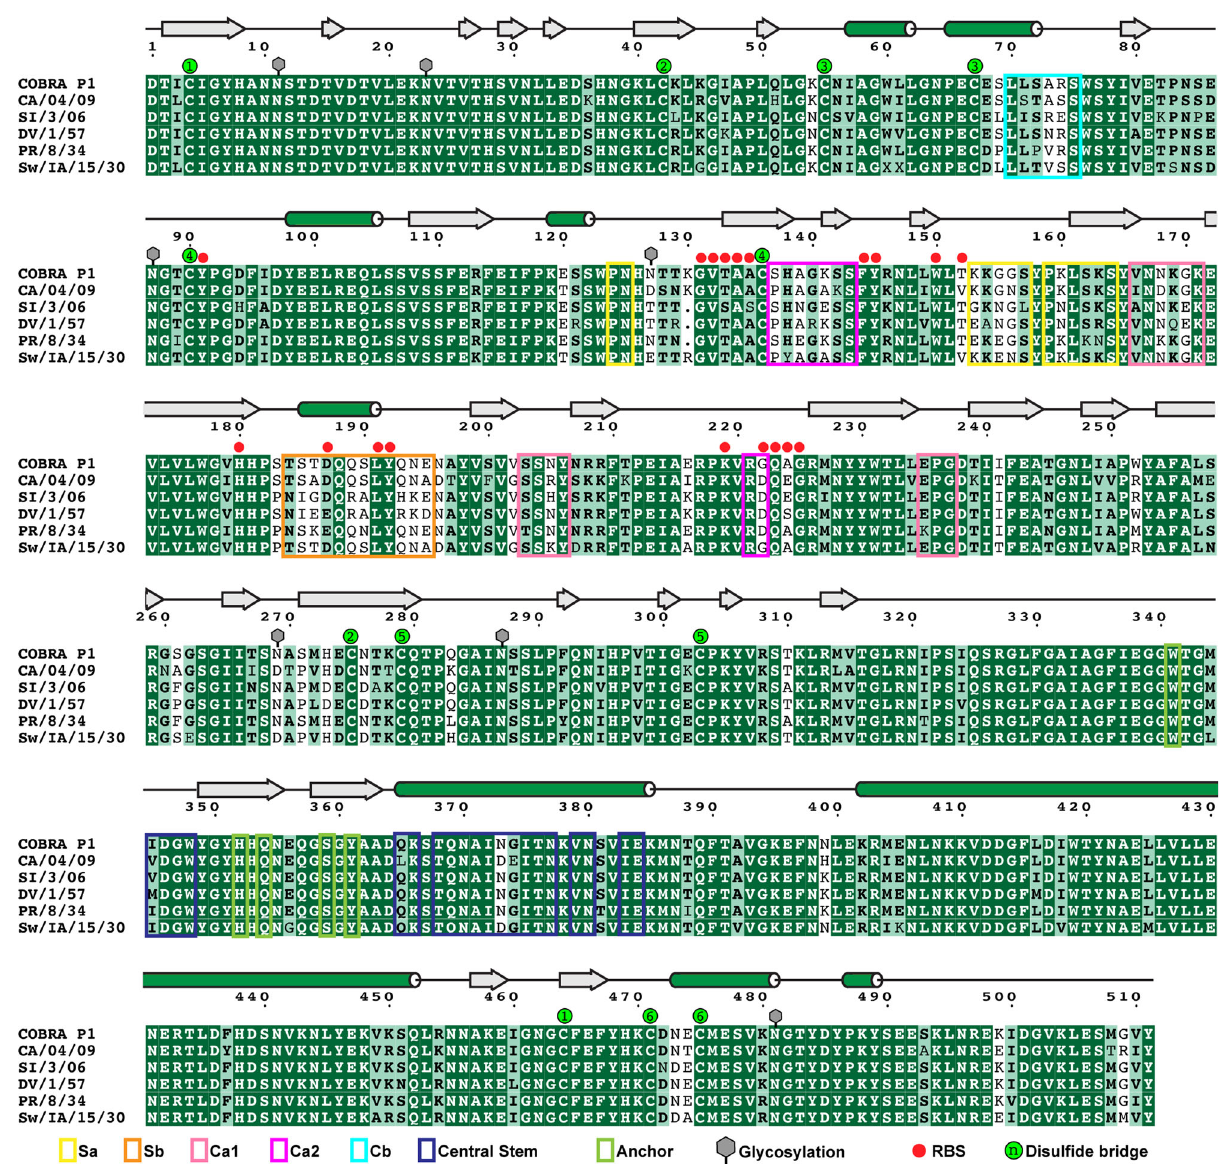
Fig. 1 Sequence alignment of HA proteins. The ectodomain of mature HA proteins for COBRA P1, A/California/04/09 (CA/04/09; Accession number ACP41105.1), A/Solomon Islands/3/2006 (SI/3/06; Accession number ABU99109.1), A/Denver/1/1957 (DV/1/57; Accession number ABD15258.1), A/ Puerto Rico/8/1934 (PR/8/34; Accession number ADX99484.1) and A/Swine/Iowa/15/1930 (Sw/IA/15/30; Accession number Q9WCD9.1) were aligned with CLUSTAL OMEGA 77 and manually checked. The initial graphic was generated with the ESPript 3.0 server 78 and annotated in Adobe Illustrator. The secondary structure assignments based on a DSSP analysis 79 of the crystal structure are denoted as silver block arrows for β -sheets and green cylinders for α -helices. H1N1pdm residue numbering is used 58 . Antigenic regions for Sa, Sb, Ca1, Ca2, Cb, Central Stem, and Anchor are shown using yellow, orange, magenta, purple, sky blue, royal blue, and bright green colored boxes. RBS, receptor binding site (red circles). N-linked glycosylation observed in the crystal structure is indicated by gray hexagons. Numbered green circles denote cysteines paired together in disul fi de